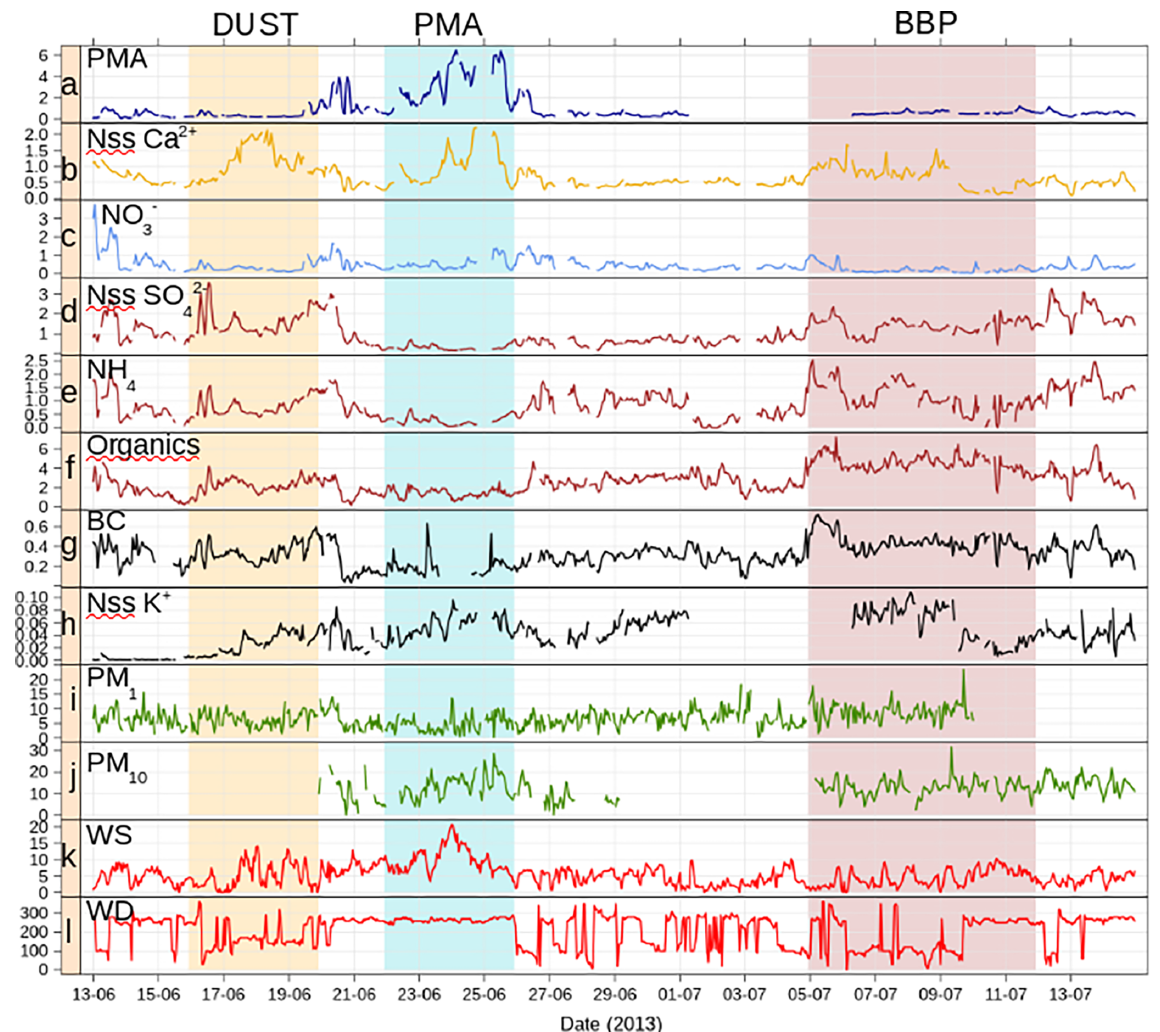
Figure 3. Time series of chemical species (inµgm − 3 ), wind speed (ms − 1 ) and direction ( ◦ ): (a) PMA mass concentration calculated from PILS-IC measurements, (b) nss-Ca 2 + mass concentration measured by PILS-IC measurements, (c) nss-NO − mass concentration measured 3 by the PILS-IC, (d) nss-SO 2 − mass concentration measured by the PILS-IC, (e) nss-NH + mass concentration measured by the PILS-IC, 4 4 (f) organic mass concentration measured by the ACSM, (g) black carbon mass concentration measured by the MAAP, (h) nss-K + mass concentration measured by the PILS-IC, (i) PM 1 mass concentration measured by TEOM PM 1 , (j) PM 10 mass concentration measured by TEOM PM 10 , (k) wind speed measured at the Semaphore, (l) wind direction measured at the Semaphore. The shaded areas correspond to the three identified periods: orange for dust, blue for primary marine aerosols (PMAs) and brown for biomass burning/pollution (BBP).